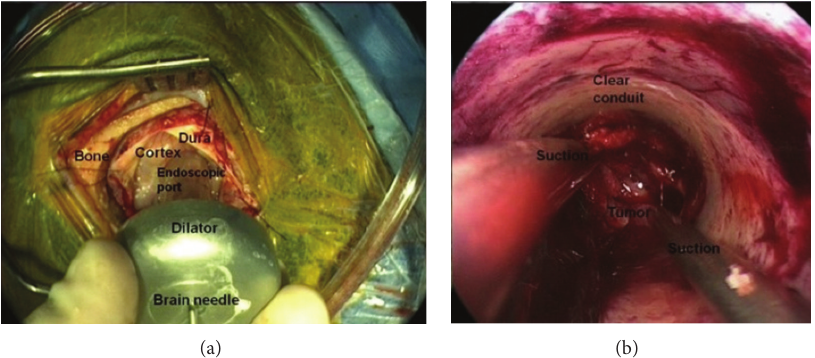
Figure 2: (a) View of the endoscopic port with dilator insertion and (b) surgical view through the endoscopic